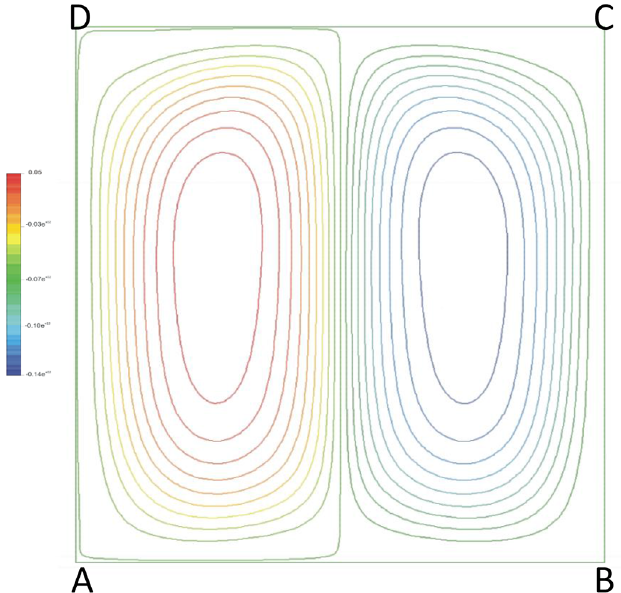
Fig. 5. Stream function contour of the square cavity with boundary condition on the walls, AB, u = 1, CD ∂ u ∂ BC, u = 0, Pr = 0.71, Ra = 10 5 . ¼ 0 , DA, u =1, n